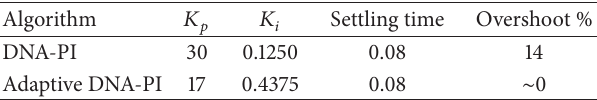
Table 2: Comparison results of DNA and adaptive DNA computing algorithms.